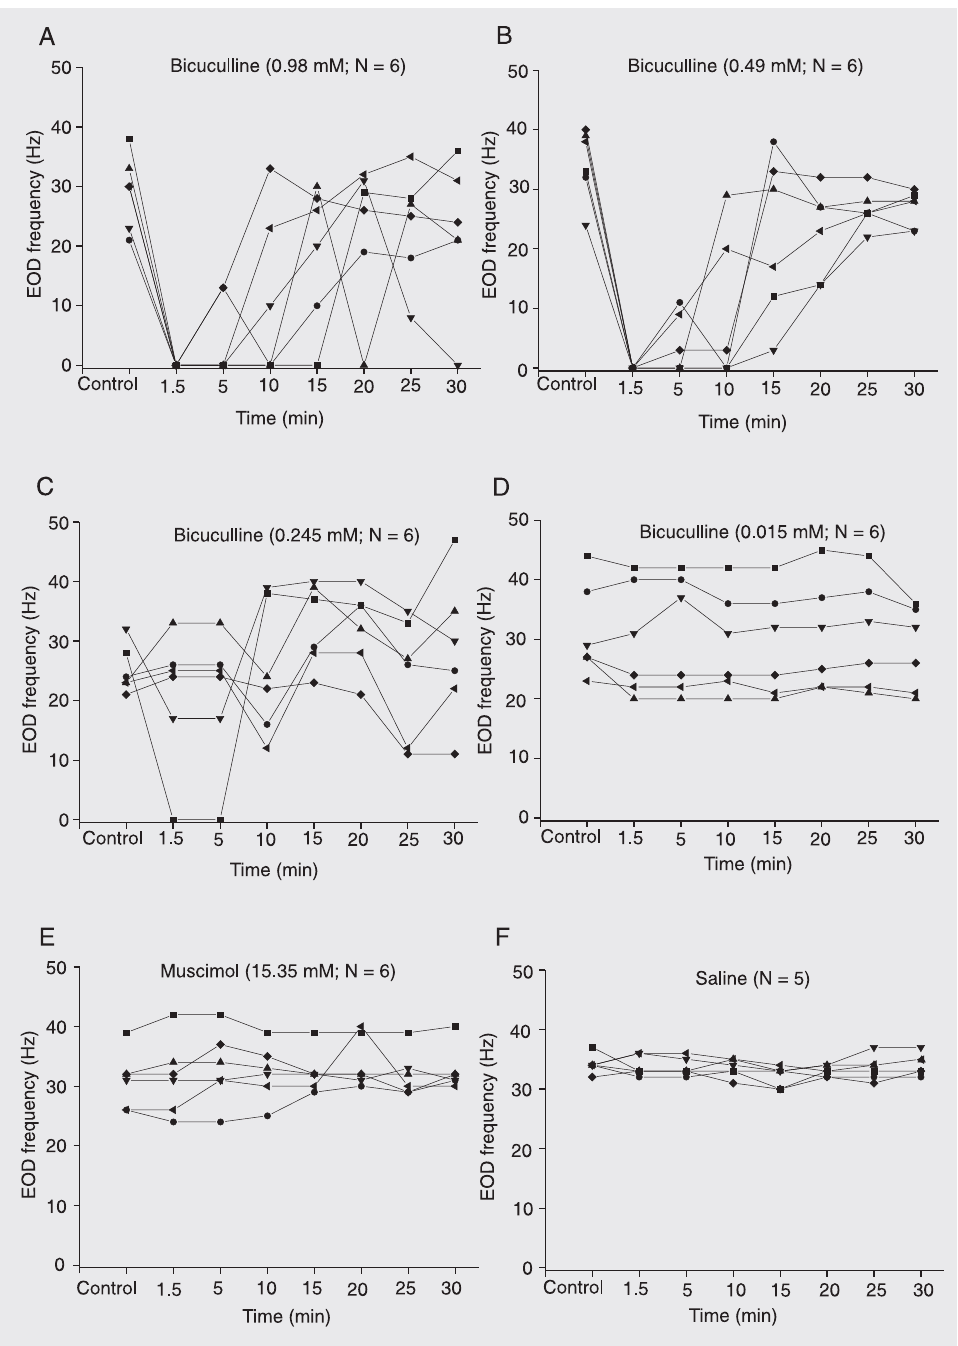
Figure 1. Time course of individual values of the electric organ discharge (EOD) frequencies (Hz) of awake Gymnotus carapo before (control) and after microinjections of different doses of bicuculline (A to D), muscimol (E) or saline (F) into the torus semicircularis dorsalis. With the higher doses of bicuculline the interruptions of the EOD persisted longer and were occasionally intermingled with partial or total resumption of activity. Muscimol and saline were